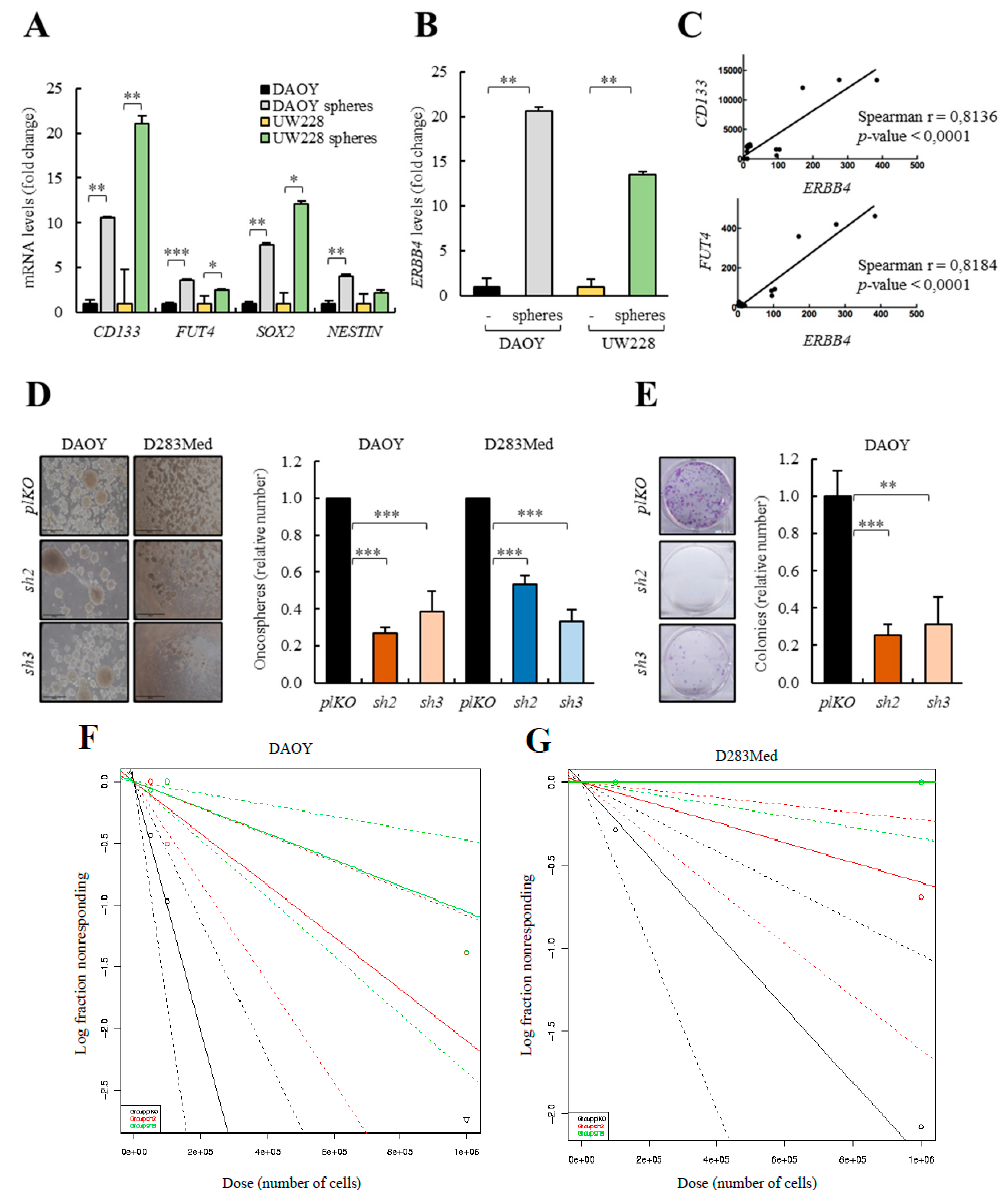
Figure 5. ERBB4 expression regulates medulloblastoma stem cell (MBSC) activity. ( A ) mRNA levels of the indicated stem cell markers of DAOY and UW228 cells grown in serum or in stem cell media as spheres ( n ≥ 3). ( B ) ERBB4 mRNA expression levels of DAOY and UW228 cells grown in serum and stem cell media ( n ≥ 3). ( C ) Correlation between CD133 and FUT4 expression levels and ERBB4 expression levels in di ff erent medulloblastoma cell lines (DAOY, UW228, D283Med, D341Med, CHLA-01-Med, and CHLA-01R-Med) ( n ≥ 3). ( D ) Representative images and quantification of the number of oncospheres formed from the indicated conditions in DAOY and D283Med cells ( n ≥ 4). Scale bars = 100 µ m. ( E ) Representative images and quantification of the number of colonies formed from the indicated conditions in DAOY cells ( n ≥ 3). ( F ) Frequency of tumor initiation after subcutaneous injection in nude mice of 1 × 10 6 , 1 × 10 5 and 5 × 10 4 DAOY cells transduced with pLKO , sh2 and sh3 . ( G ) Frequency of tumor initiation after subcutaneous injection in nude mice of 1 × 10 6 and 1 × 10 5 D283Med cells transduced with pLKO , sh2 and sh3 . The incidence of tumor initiation was measured using the ELDA platform (black line represents pLKO condition, red line represents sh2 , and green line represents sh3 ). * p ≤ 0.05; ** p ≤ 0.01; and *** p ≤